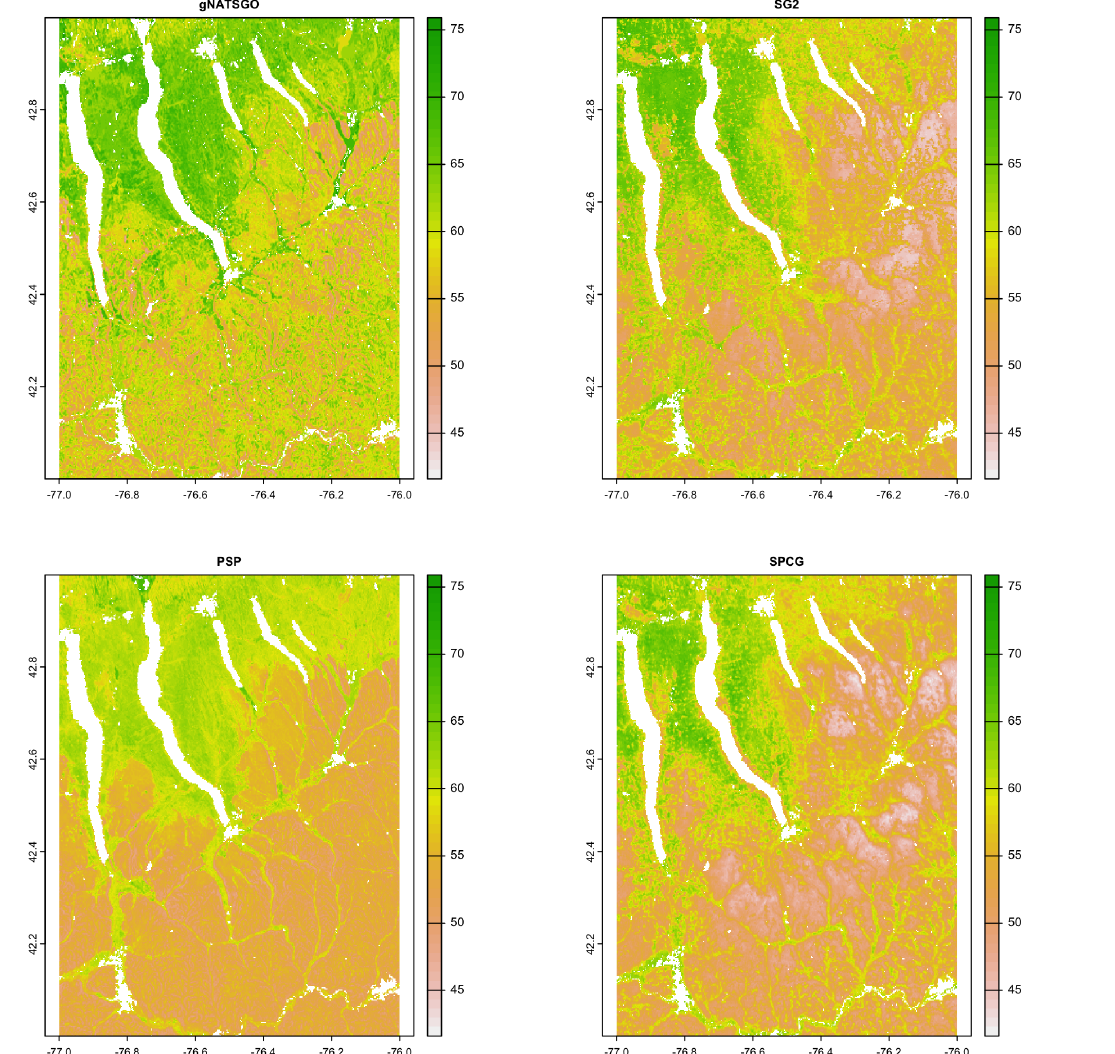
Figure 7. Topsoil (0–5cm) pH × 10, according to gNATSGO and DSM products. See the text for a discussion.